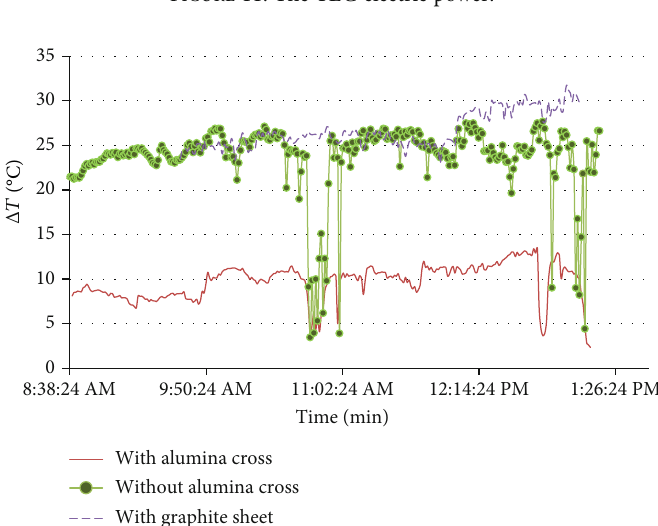
Figure 11: The TEG electric power.